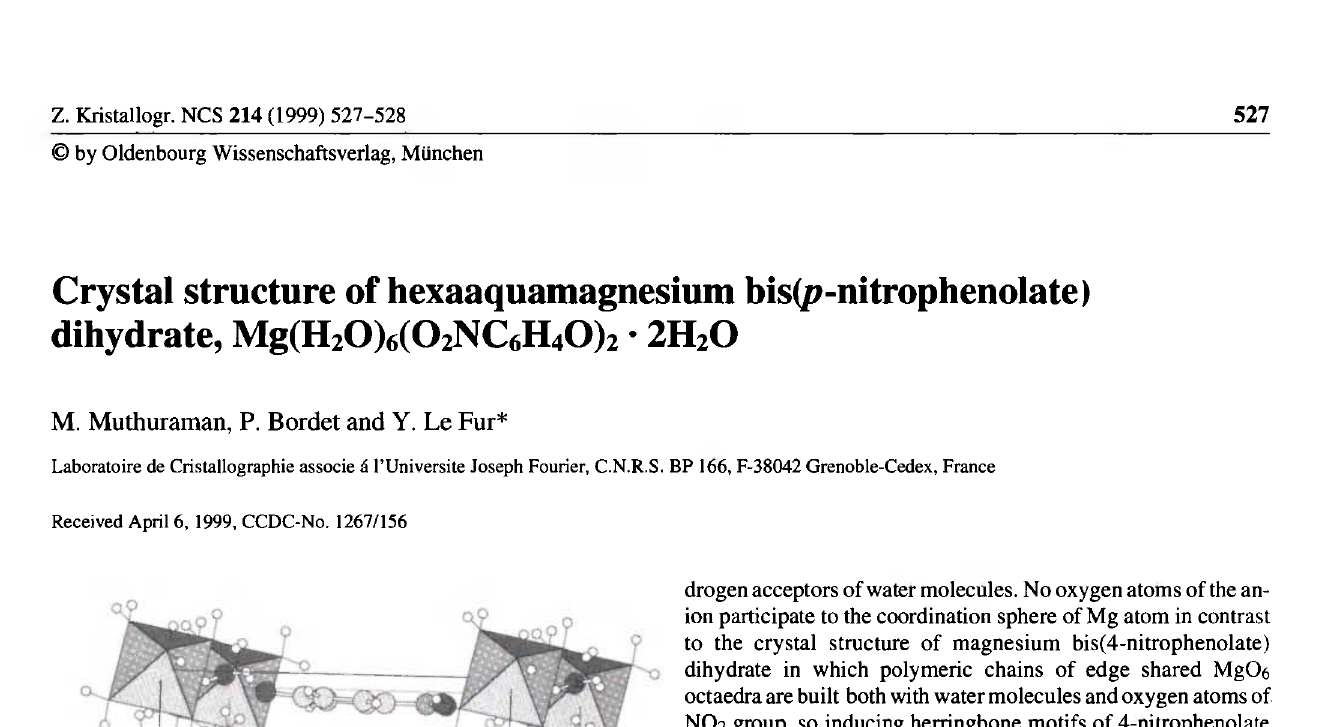
Table 1. Data collection and handling.